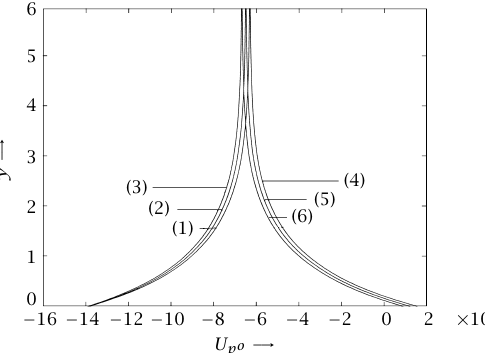
Figure 4.4 . Outer flow axial velocity component of particle U p o for R = 500, 4 = 0 . 05, t = 1. (1) X = − 1, λ = 0 . 01, (2) X = − 1, λ = 0 . 16, (3) X = − 1, λ = 0 . 31, (4) X = 1, λ = 0 . 01, (5) X = 1, λ = 0 . 16, (6) X = 1, λ = 0 .